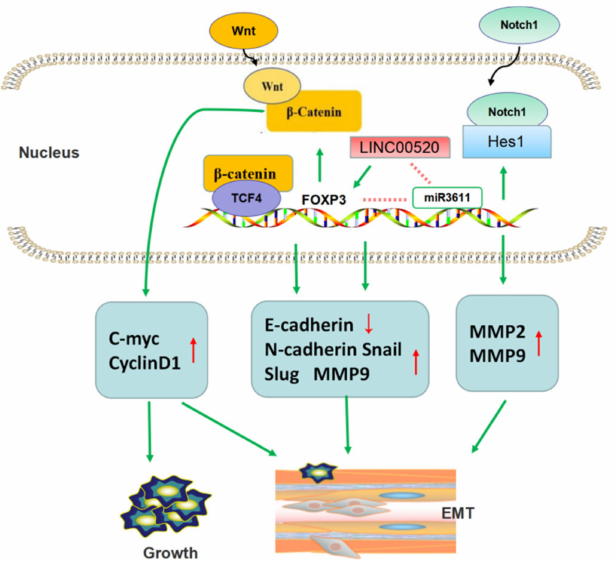
Figure 5. FOXP3 promotes tumor metastasis by promoting EMT in NSCLC. FOXP3 participated in Wnt/ β -catenin pathway and Notch1/Hes1 pathway to regulate expression of EMT-related